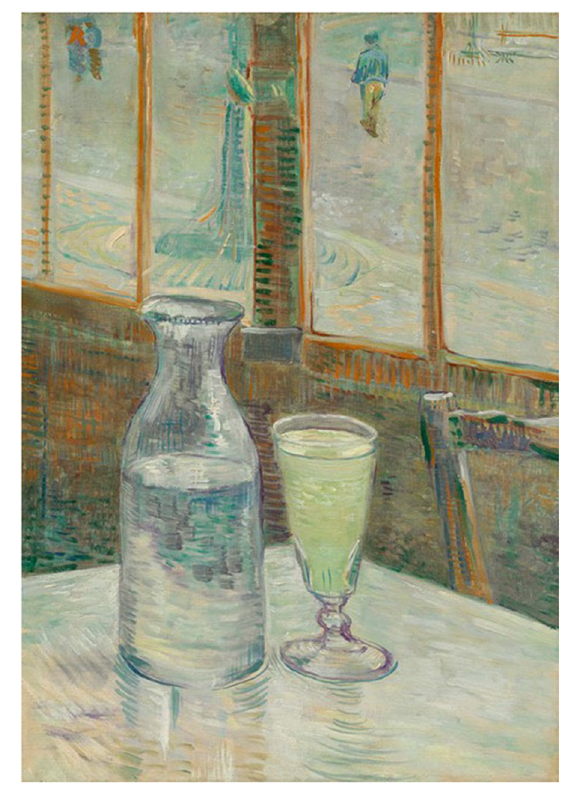
Fig. 2 Still life: Café table with absinthe (February/March 1887), Van Gogh Museum, Amsterdam, The